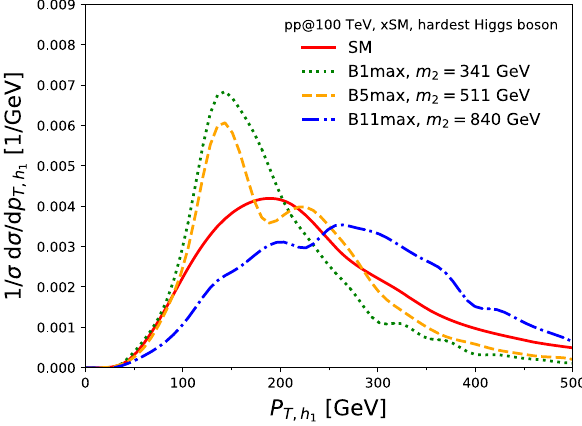
Fig. 9 The (normalised) transverse momentum distribution of the hardest Higgs boson in triple h 1 production within the xSM at the FCC-hh at 100 TeV, reconstructed from Monte Carlo truth with no cuts applied. We show three benchmark points from [44], as well as the SM expectation for comparison